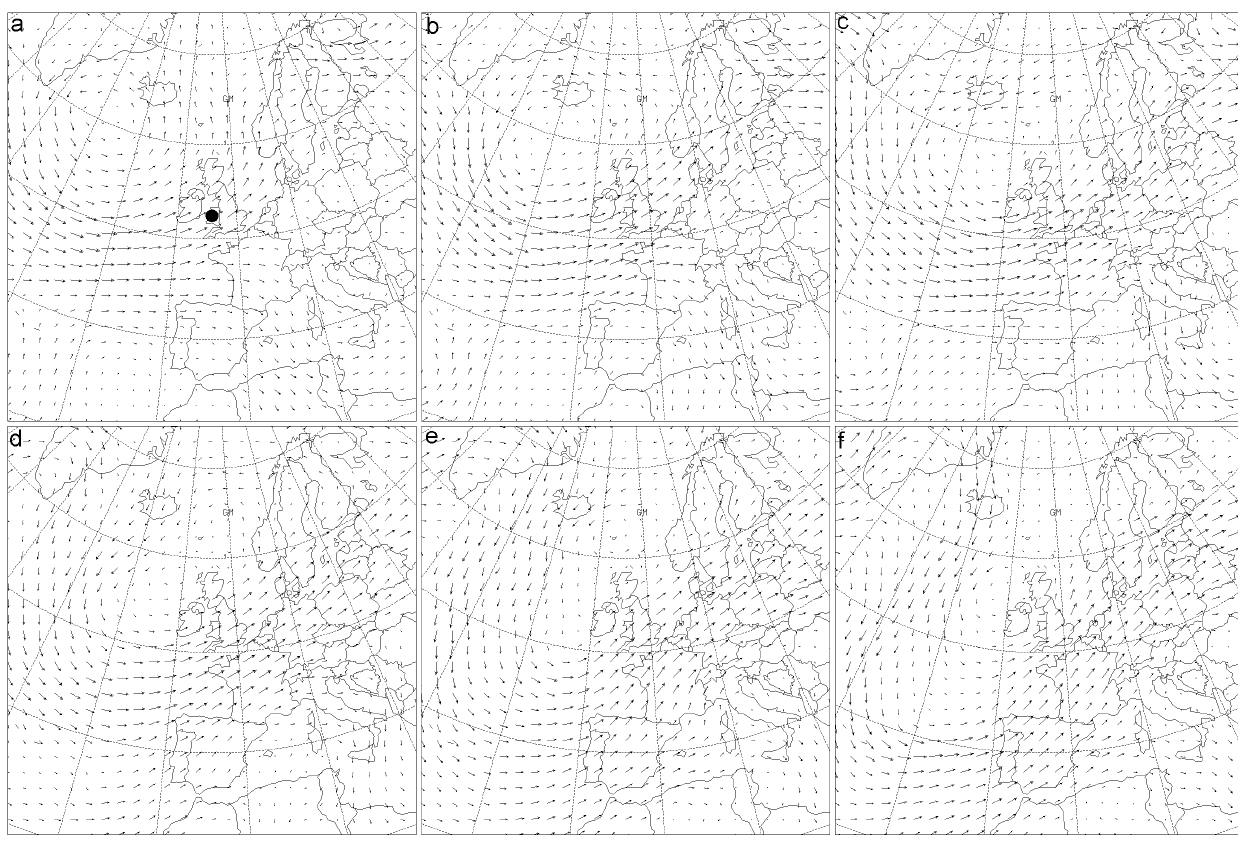
Fig. 2. Horizontal wind vectors at 500mb above western Europe, at 12 UTC on (a) 14, (b) 15, (c) 16, (d) 17, (e) 18, (f) 19 August 2000. The maximum vector length is 30 m s − 1 . In (a), a dot marks the radar